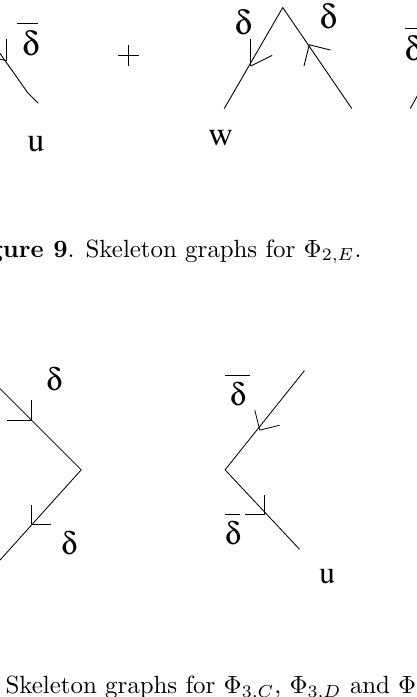
Figure 10 . Skeleton graphs for (cid:8) 3 ;C , (cid:8) 3 ;D and (cid:8) 3 ;E .